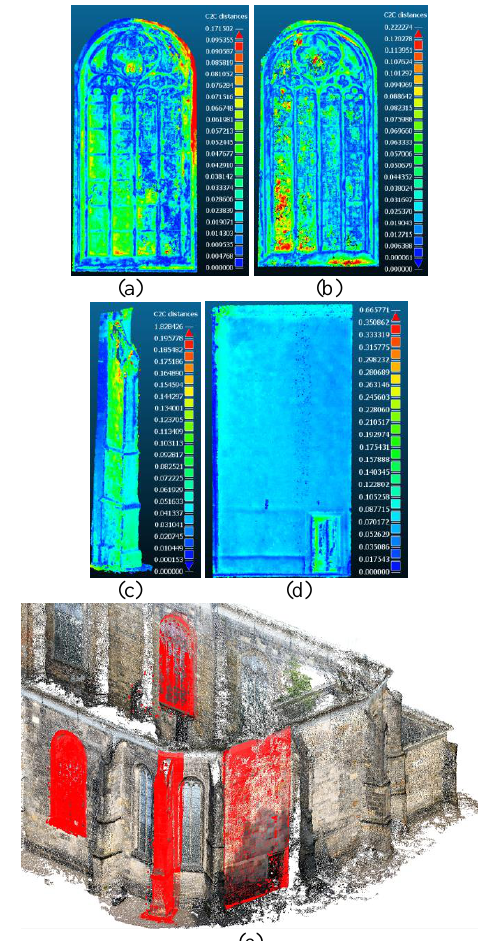
Figure 13. Video based point cloud after filtering (a) C2C comparison of window I. (b) C2C comparison of window II. (c) C2C comparison of the column. (d) C2C comparison of the facade. (e) Video based point cloud and validation parts in